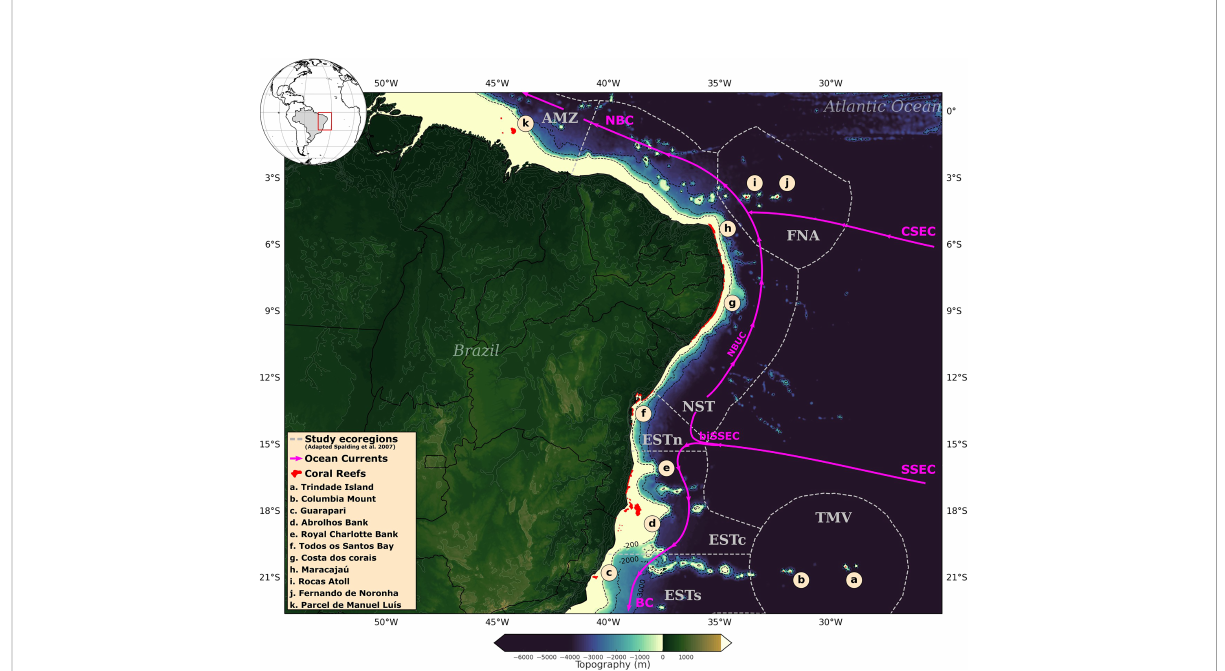
FIGURE 1 Coral reefs geographic distribution along the Brazilian continental margin (in red), according to UNEP-WCMC et al. (2018) and Magris et al. (2021). Ecoregions adapted from Spalding et al. (2007) (in grey): Eastern-south (ESTs); Eastern-center (ESTc); Eastern-north (ESTn); Northeastern (NST), Amazon (AMZ), Fernando de Noronha-Atol das Rocas (FNA), Trindade-Martim Vaz Islands (TMV). Simpli fi ed diagram of surface ocean currents (in pink) according to Stramma and England (1999); Soutelino et al. (2013): NBC, North Brazil Current; NBUC, North Brazil Undercurrent; CSEC, Central branch of the South Equatorial Current; SSEC, Southern branch of the South Equatorial Current; biSSEC, bifurcation of the South Equatorial Current southern branch; BC, Brazil